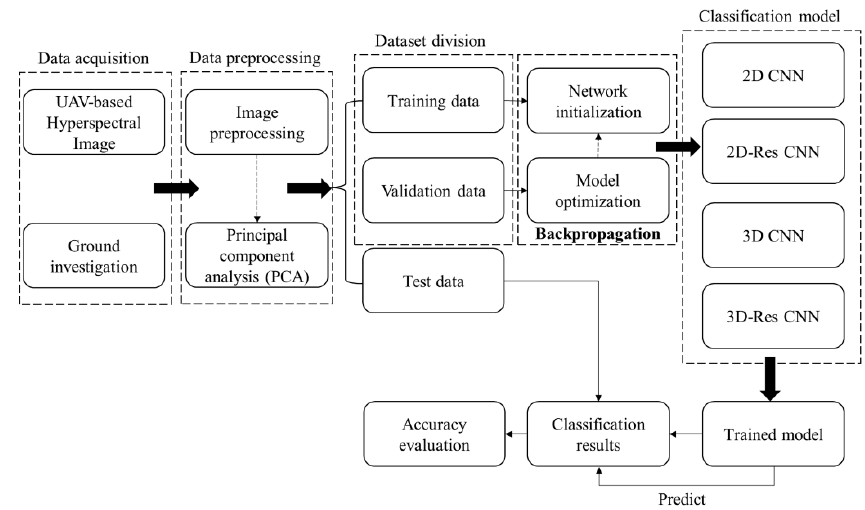
Figure 5. The overall workflow of the study.